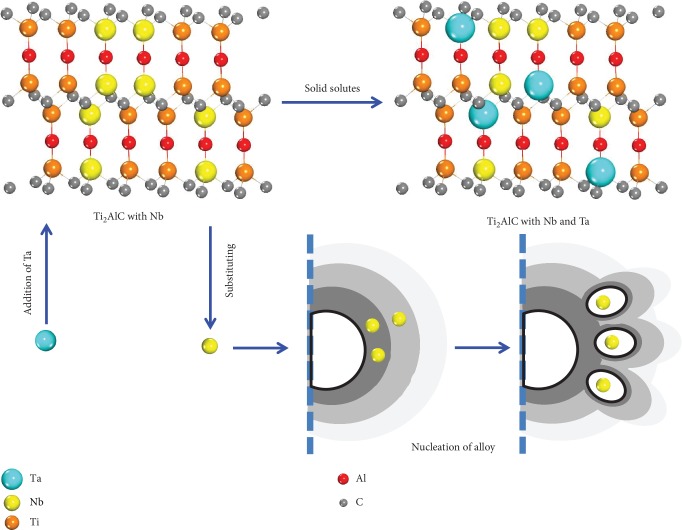
Schematic diagram of effects of Ta on the Ti2AlC phase.